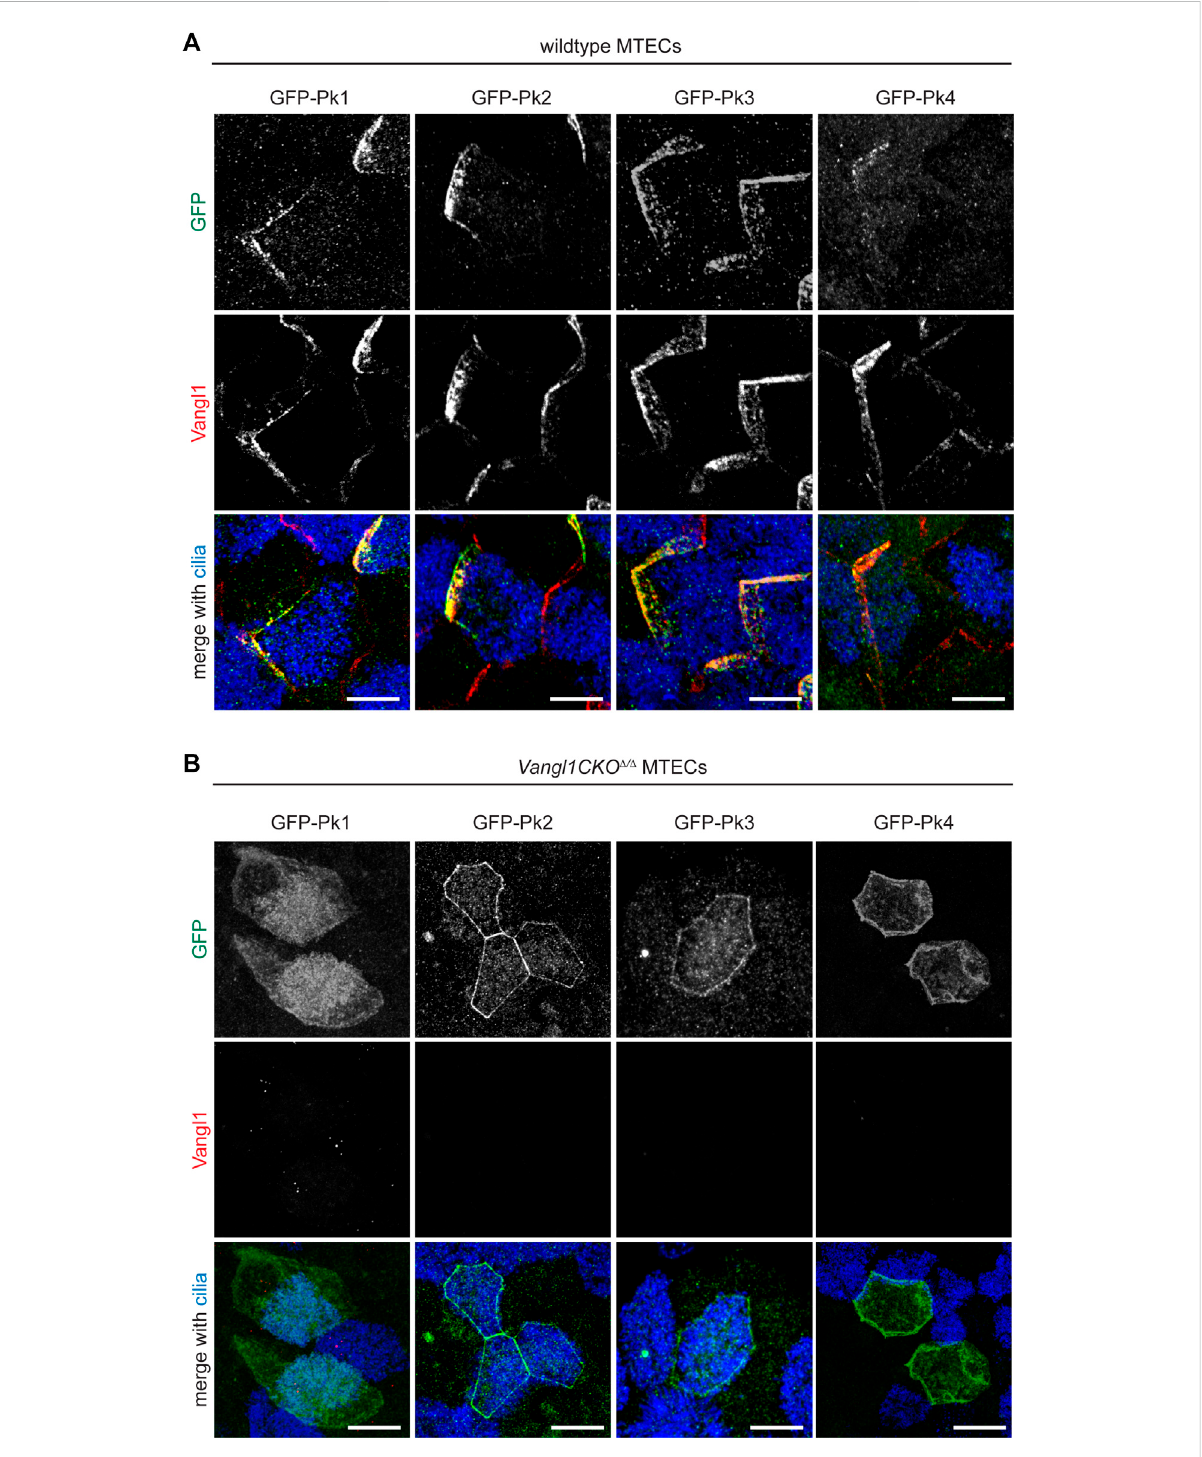
Vangl1isrequiredforPk1-4crescentlocalization intheairwayepithelium.Wildtype (A) and Vangl1CKO Δ / Δ (B) MTECstransducedwithGFP-Pk1- 4 lentivirus were immunolabeled with GFP (green), Vangl1 (red) and ac. α -Tubulin (blue) antibodies. GFP-Pk1-4 can form crescents in all transduced cells, including both multiciliated and non-ciliated cells in wildtype, but not Vangl1CKO Δ / Δ MTECs. Scale bar, 5 μ